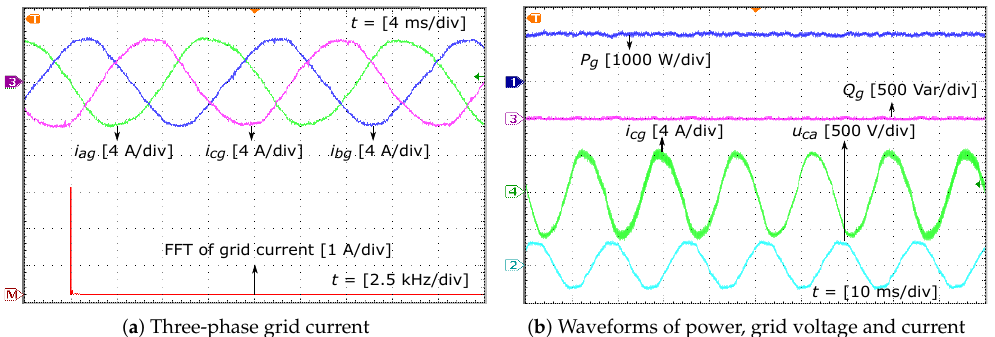
Figure 14. Experimental results of the proposed method in steady-state with P g = 1300 W and Q g = 0 Var.